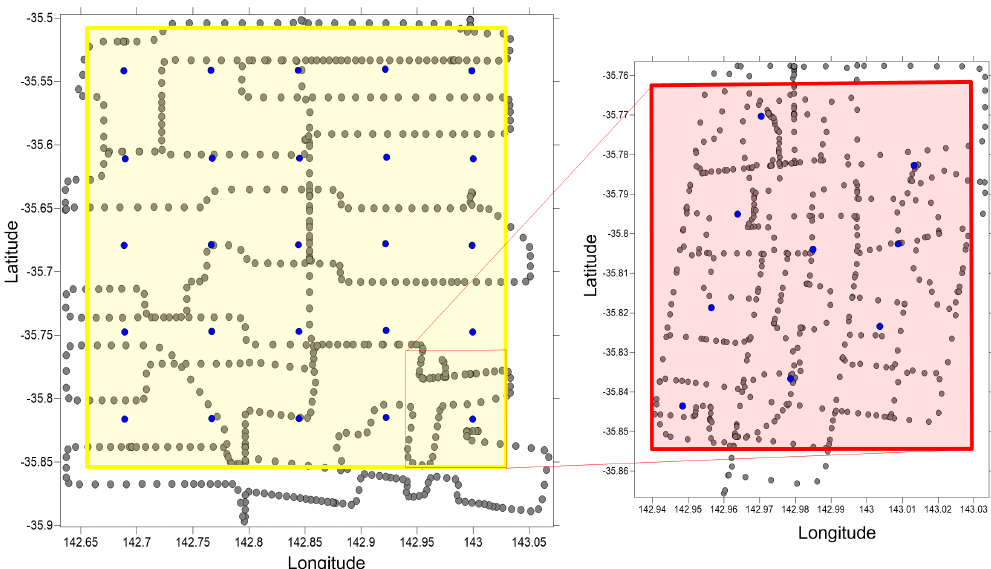
Figure 2. Rover survey extents and sampling points for the broad-scale and intensive-scale measurement campaigns. Sampling points from April 2016. The yellow box ( ∼ 36km × 36km) delineates the broad-scale survey extent and the red box ( ∼ 10km × 10km) delineates the intensive-scale survey extent. Blue points in each figure represent approximate locations of gravimetric soil moisture sampling